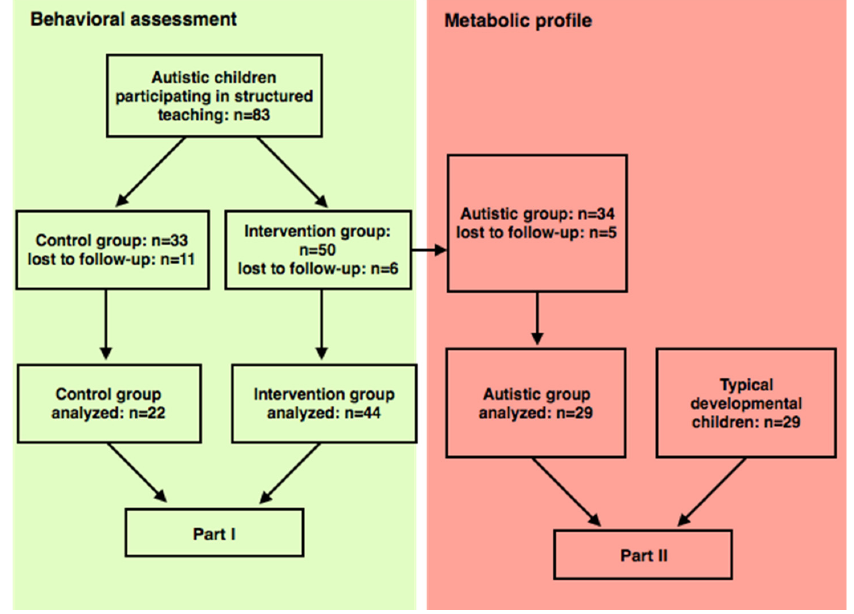
Figure 2. Flowchart of study design and patient follow ‐ up.